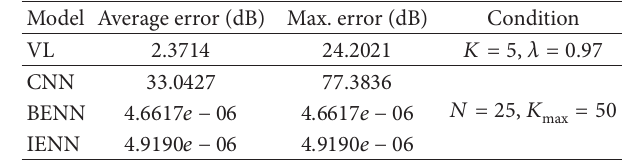
Table 3: Mean error 𝜎 and maximum transient error 𝜎 max of four behavioral models with LFM signal input.